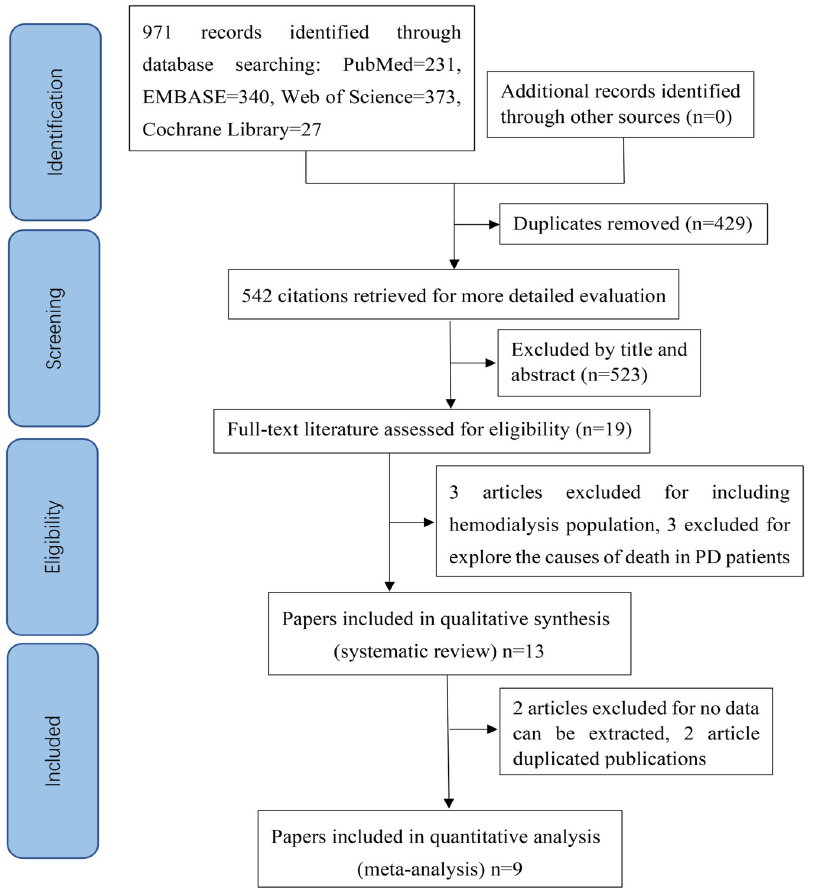
Fig 1. Flow diagram of PRISMA presenting the process of search and selection of studies. PRISMA, Preferred Reporting Items for Systematic Reviews and Meta-Analyses.